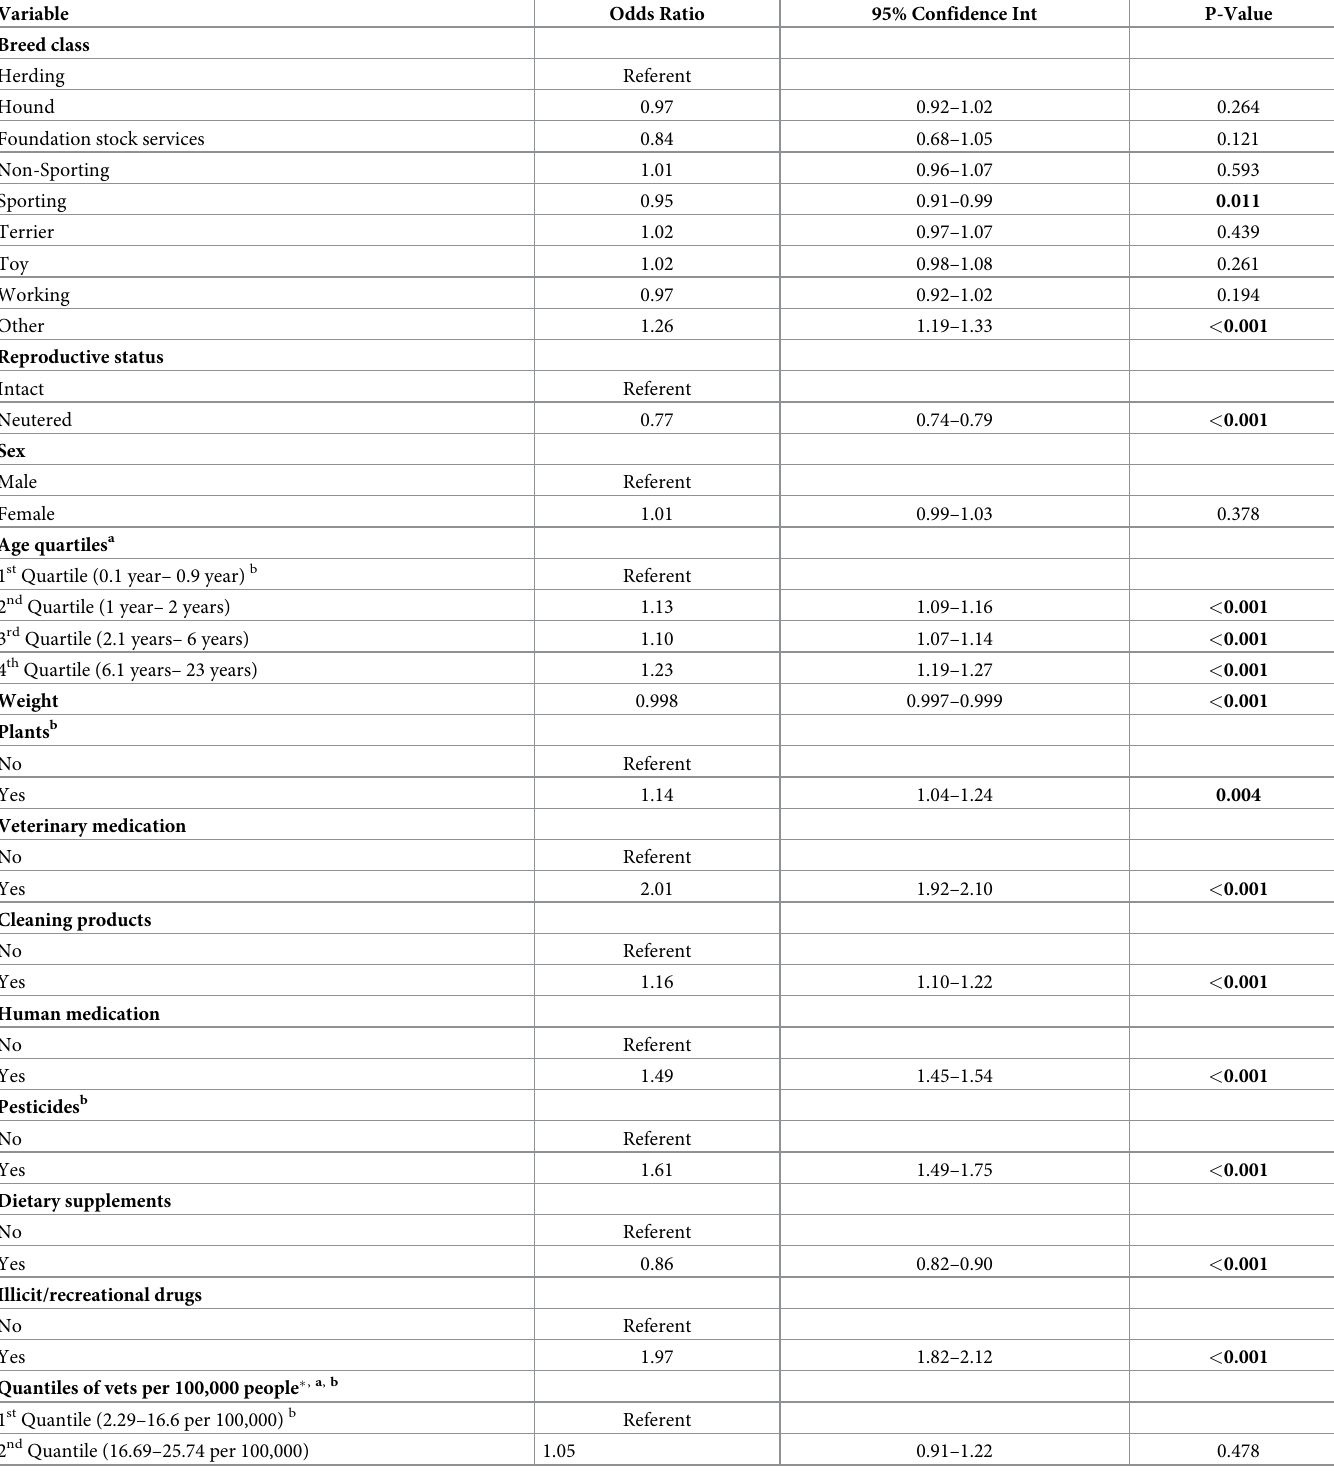
Table 3. Results of mixed effects multivariable logistic regression concerning the associations between source of call (1 = Veterinarian, 0 = Public) to the APCC (2005–2014) and dog demographics, type of toxicant, season, year, and access to veterinary